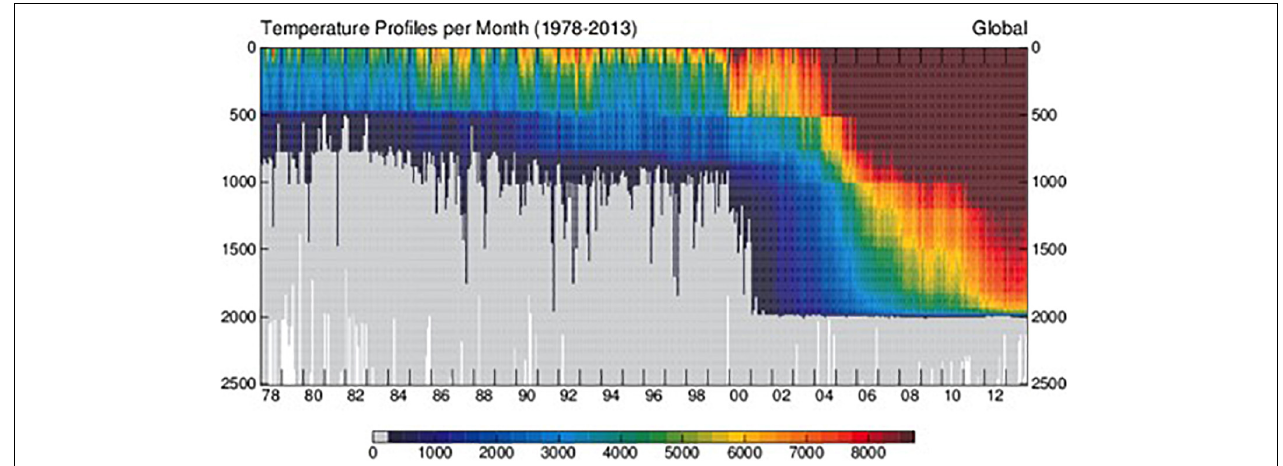
FIGURE 2 | Global availability of in situ temperature profiles by vertical depth from 1978 to